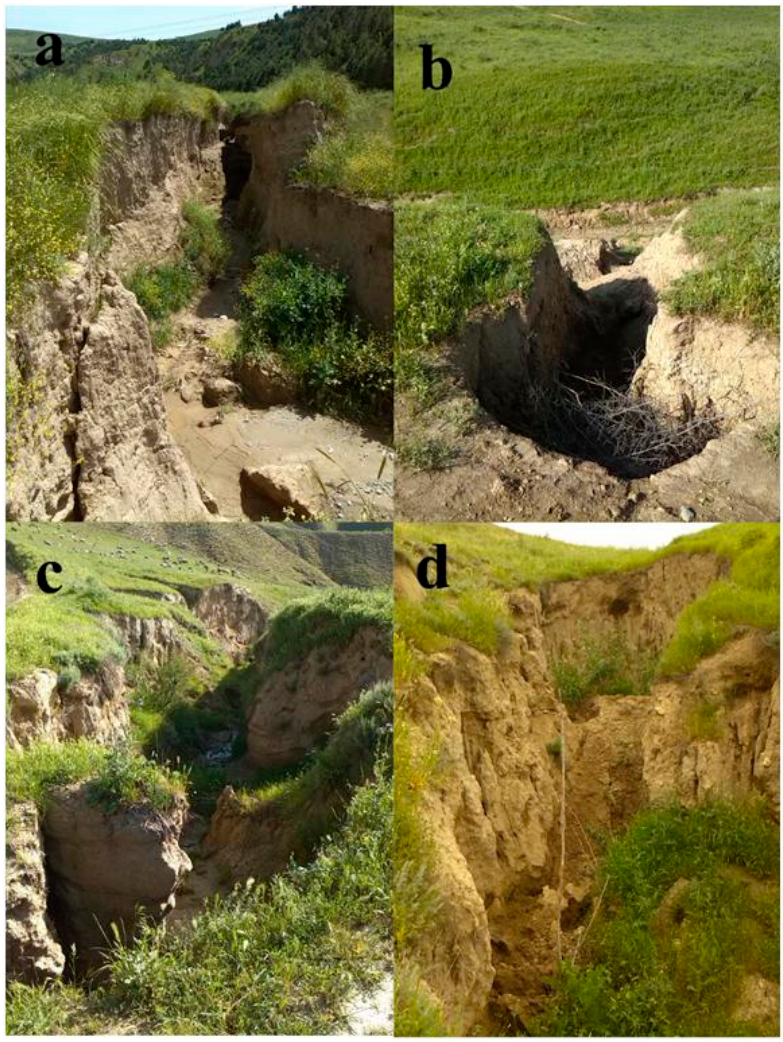
Figure 3. Examples of some gullies in the study area. ( a ) Lat: 377007.7; Long 4183089. ( b ) Lat: 392843.2; Long 4176928.2. ( c ) Lat: 389282.7; Long 4173468.7. ( d ) Lat: 388929.7; Long